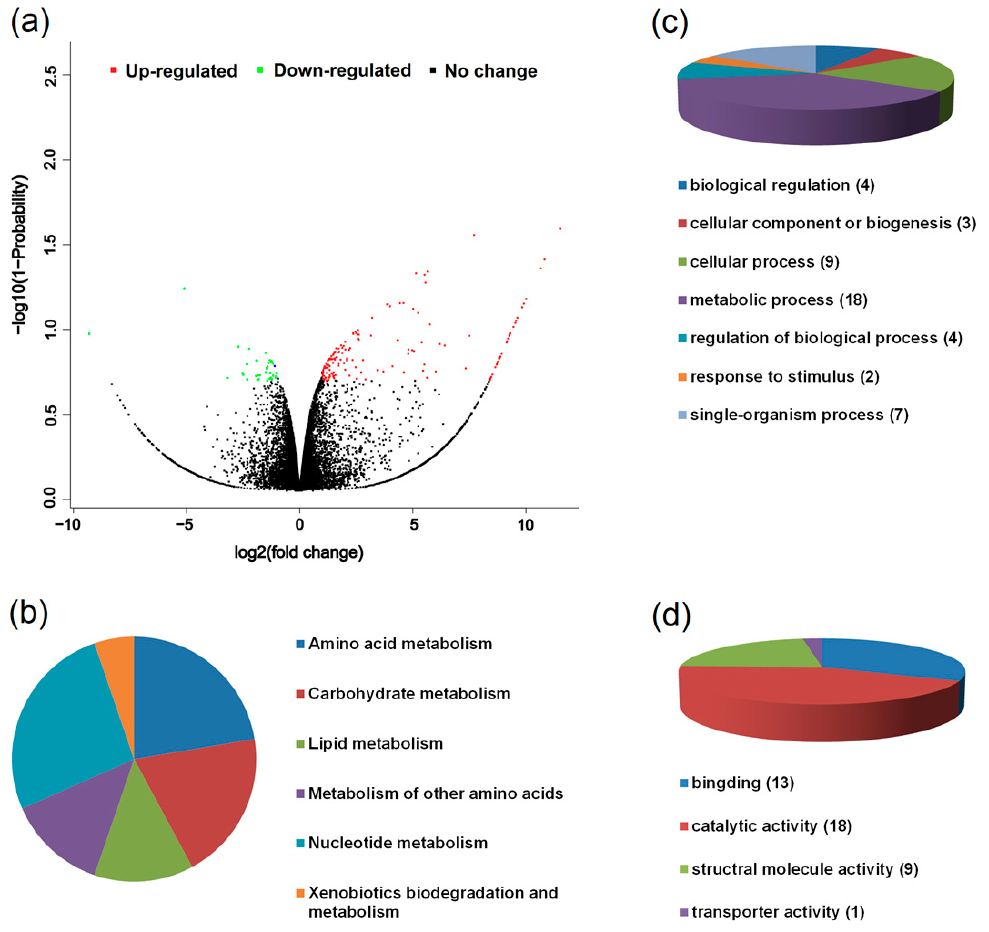
Figure 4. Summary of the sequence annotation of differently expressed genes between the two host races of Acyrthosiphon pisum on Medicago sativa based on ( a ) a volcano plot of the differently expressed genes, ( b ) KEEG pathway analyses, ( c ) biological control and ( d ) molecular function. “Up-regulated” or “Down-regulated” indicates genes are higher or lower in the Pisum host race compared to the Medicago host race. “No change” indicates genes with no significant difference between the two host races. Table 2. Selected related genes differentially expressed between the Medicago host race and Pisum host race.